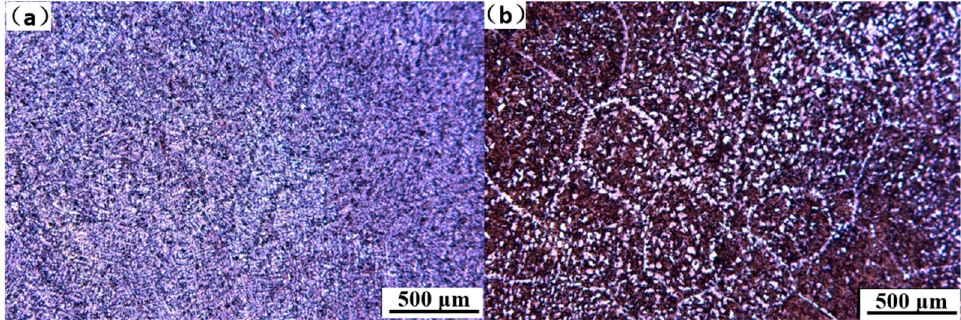
Figure 9. Microstructure of the corner of the continuous slab. ( a ) Microstructure of the corner of the ‘oscillation mark’ area, and ( b ) microstructure of the corner of the ‘non-oscillation mark’